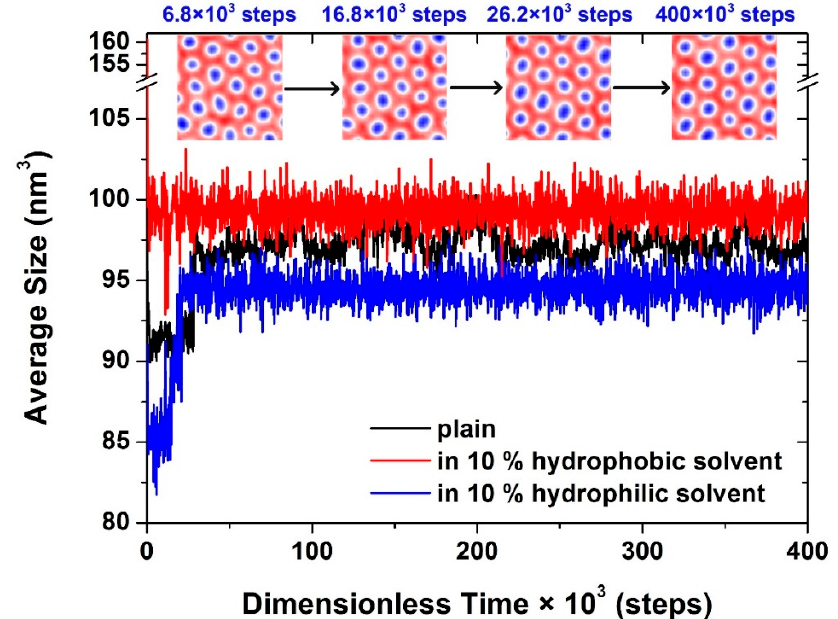
Figure 3. Evolution of the average size of the cylindrical structure with simulation time in three different systems, i.e., the plain system, the system doped with 10% hydrophobic solvent and the system doped with 10% hydrophilic solvent denoted by black, red and blue lines, respectively. The pictures for the hydrophilic solvent beads are displayed above at representative time, whose color mapping is in blue-white-red.